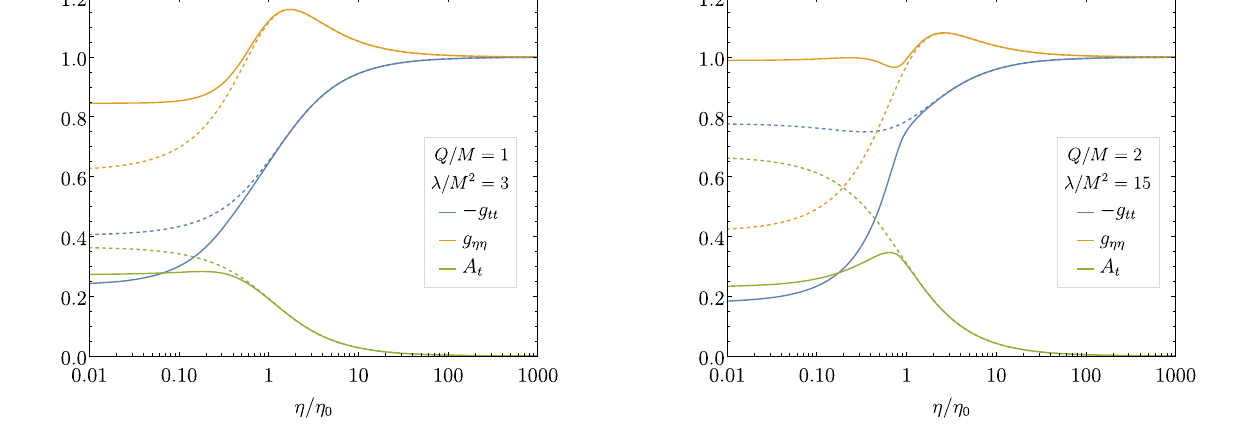
Fig. 1 g tt , g ηη and A t vs η/η 0 for coupling function (i) and Q / M = 1 and λ/ M 2 = 3. Dashed: RN solution of the same mass and charge